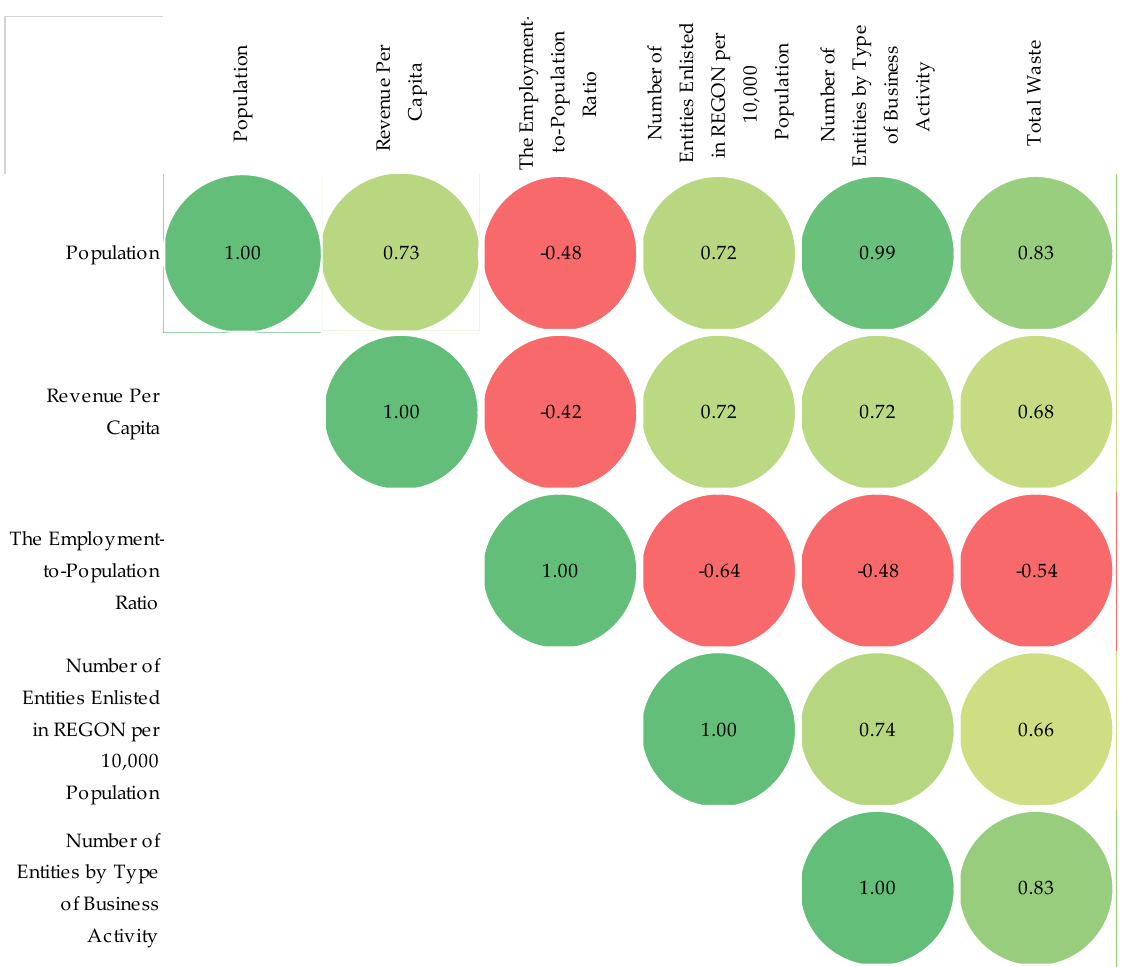
Figure 6. Correlation between input and output parameters for MSW prediction. Table 1. Description of the dataset.